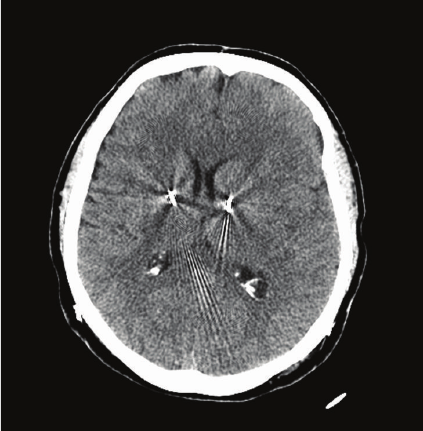
Figure 2: CT head at follow-up visit demonstrates resolution of